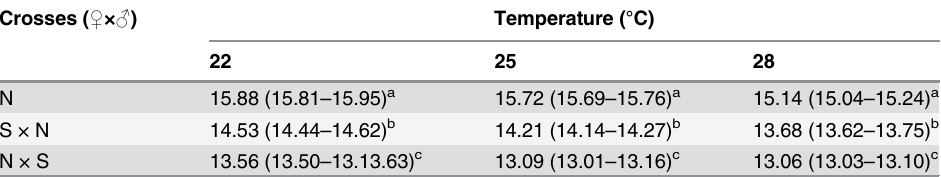
Table 1. Critical daylength (h) of the northernmost Harbin (N) and the southernmost Ledong (S) strains of Ostrinia furnacalis and their F 1 progeny based on their responses to various photoperiods at 22, 25 and 28°C.